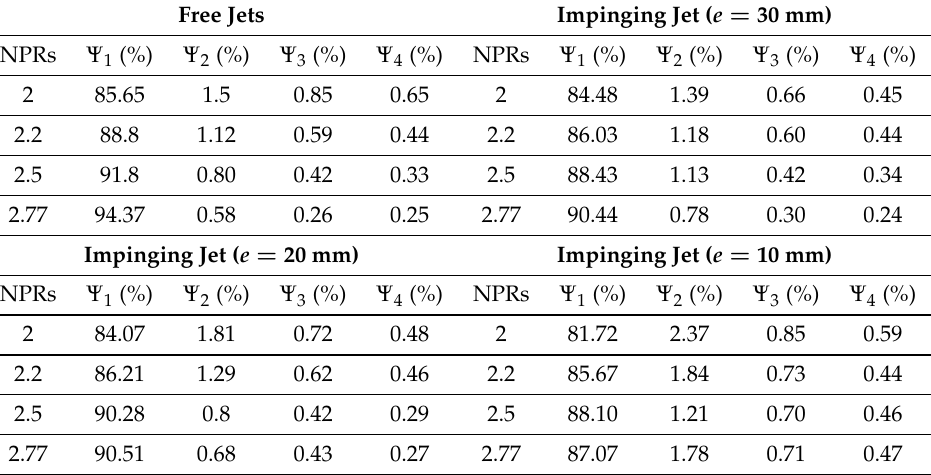
Table 2. Flow kinetic energy fractions contained in low-order POD modes obtained from POD velocity decomposition to 2D2C PIV velocity vector fields for free jets and impinging jets with various nozzle-to-plate distances e = 30 mm, 20 mm, and 10 mm, and different values of NPRs, i.e., NPR 1 =